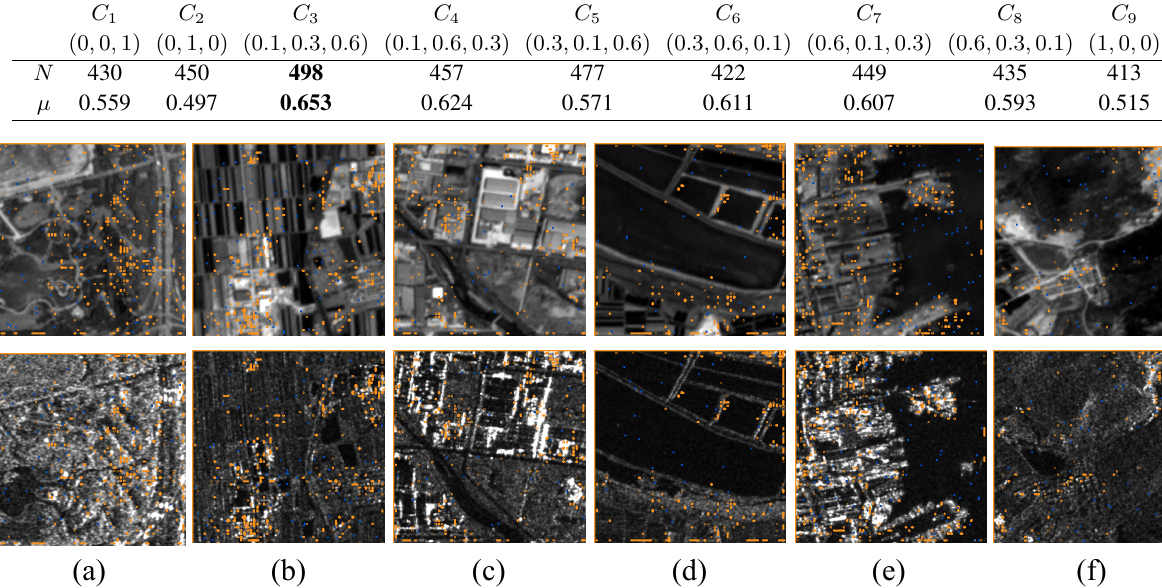
Table 2. Weight combination and result, where N, µ denote the average number of matching points and mean value of REME, respectively.